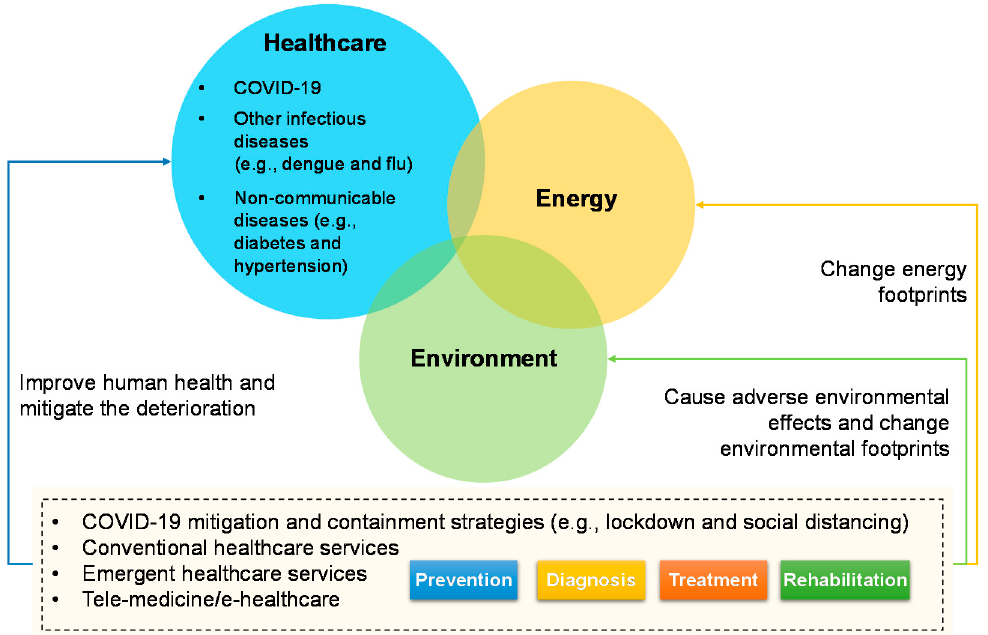
Figure 2. The healthcare–energy–environment system during the COVID-19 pandemic. COVID-19 challenged healthcare systems, changed population lifestyles, reshaped energy consumption and living environment in society, and further triggered a series of chain reactions in the healthcare–energy–environment system. Various observations and region or single sector, e.g., the healthcare impact in Latin America [16] and India [17],